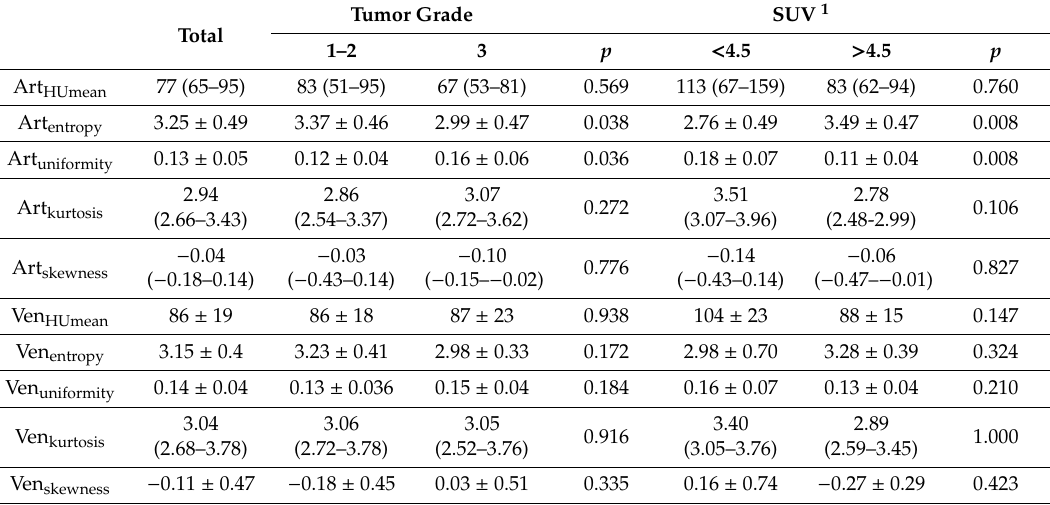
Table 2. First-order texture analysis parameters in the arterial and venous phase with ANOVA or Kruskal–Wallis tests for the comparisons between di ff erent tumor grade (G) and SUV